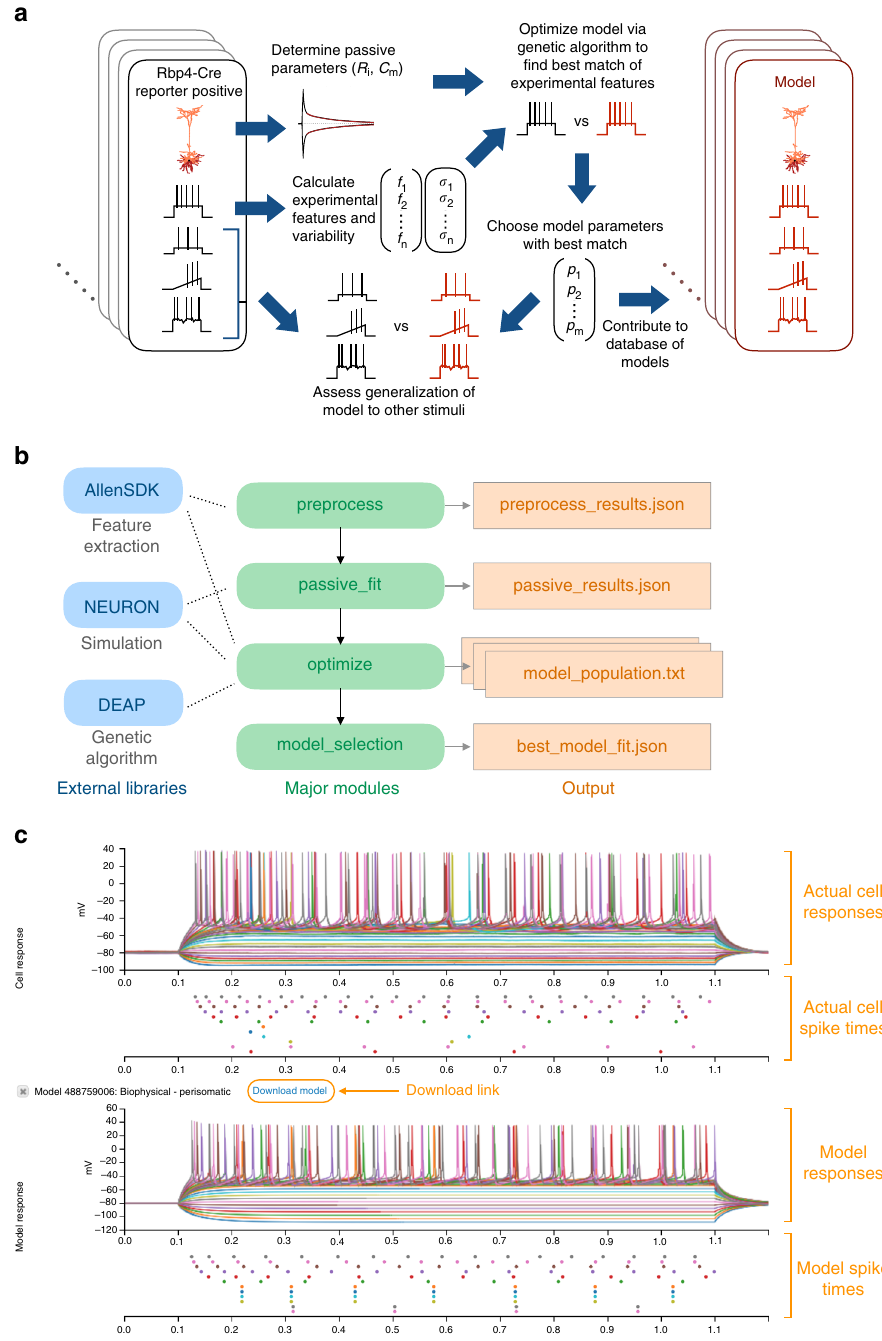
Fig. 1 Overview of model fi tting procedure and resources. a Schematic showing the steps involved in using the standardized data from individual neurons in the Allen Cell Types Database to generate optimized models that reproduce aspects of fi ring patterns. b Schematic illustrating the structure of the code, including external open source libraries (blue), major modules for model optimization (green), and key output fi les (orange). Note that the optimization module speci fi cally is written to be run automatically in a parallel fashion. c Screenshot of published models alongside the experimental data from the Allen Cell Types Database web application. Annotations to the screenshot are in orange. Note that multiple sweeps of 1 s long hyperpolarizing and depolarizing current steps are overlaid in different